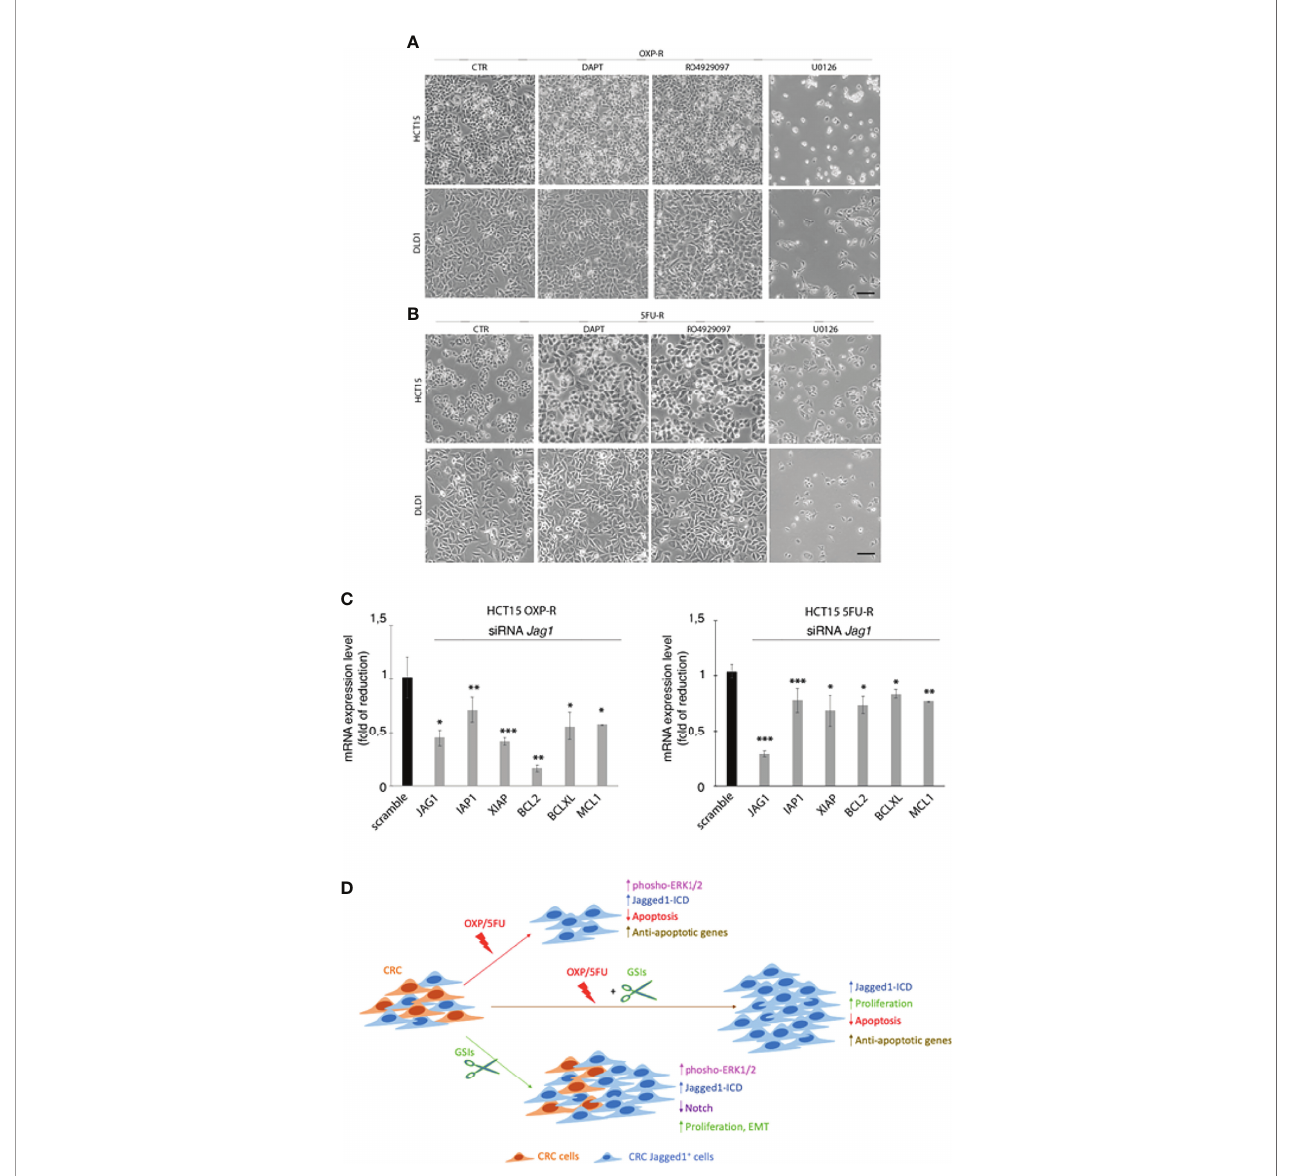
FIGURE 4 | The inhibition of Jagged1 signaling sensitizes the CRC cells to chemotherapy. (A) Representative plate area of OXP-R and (B) 5FU-R CRC cells, treated for 24 h with 10 pmol/ m l of DAPT and RO4929097 and 30 pmol/ m l of U0126. Scale bar, 200 m m. (C) The expression analysis of iap1, iap2, xiap, bcl2, bclXl , and mcl1 mRNAs was performed by qRT-PCR in OXP-R and 5FU-R HCT15 cells, silenced for Jagged1 . Data are reported as fold changes ± SD after intrasample normalization to the level of GAPDH . All data are representative of at least three independent experiments, each in triplicate. * p < 0.05; ** p < 0.01; *** p < 0.001 (Student ’ s t -test). (D) The cartoon summarizes the role of Jagged1 in chemoresistance. In detail, GSIs (green arrow) inhibit Notch signaling, but strongly trigger the Jagged1 reverse signaling by activating the ERKs cascade that induces a huge accumulation of Jag1-ICD. GSIs, via Jag1-ICD, sustain the proliferation and migration/invasion of CRC cell lines. Similarly, the chemotherapeutics agents OXP/5FU (red arrow) lead to Jagged1 processing, through the activation of ERKs. Jag1-ICD, induced by OXP/5FU, enhances the expression of several anti-apoptotic genes, supporting the growth of a chemoresistant Jagged1-positive subpopulation (OXP-R and 5FU-R). Finally, the combination of GSIs and OXP/5FU (brown arrow) sustains the Jag1-ICD-dependent signaling and reinforces the activation of pro-survival and anti-apoptotic events, unveiling the role of Jag1-ICD in mechanisms of